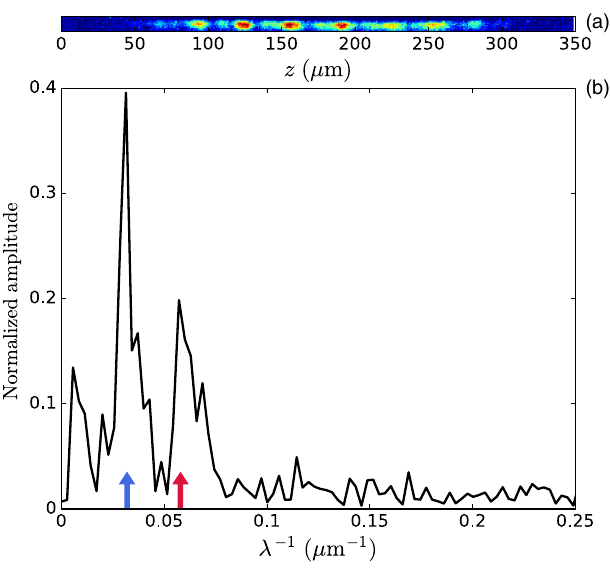
FIG. 3. (a) Image at ω ¼ ð 2 π Þ 200 Hz. (b) Spectrum showing the primary peak, which corresponds to λ , and the secondary F peak due to the resonant mode. The blue and red arrows indicate the calculated values for λ − 1 and λ − 1 , respectively, for these of the F F R [15]. parameters. Here, Δ B ¼ 35 G, but, since a ð B Þ is a nonlinear R function of Δ B , the bounds a þ ¼ 12 a 0 and a − ¼ − 0 . 9 a 0 are not ¼ t ¼ 20 symmetrically located about ¯ a ¼ 4 . 2 a 0 . Also, t m h